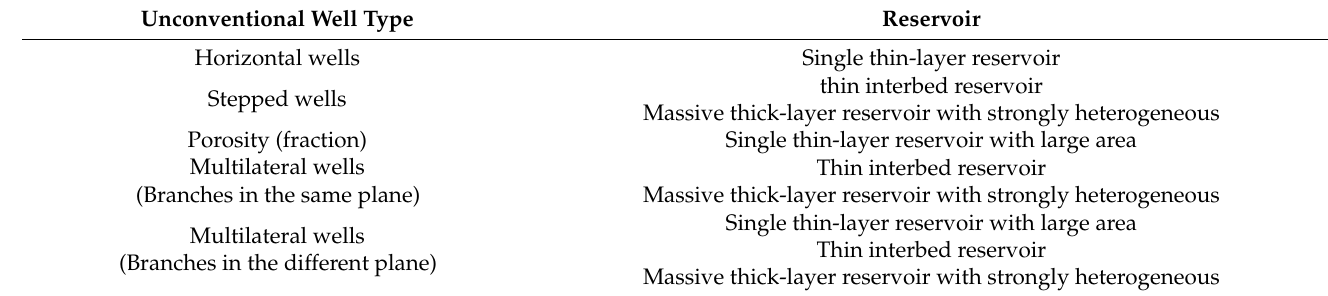
Table 6. Initial adaptation table.